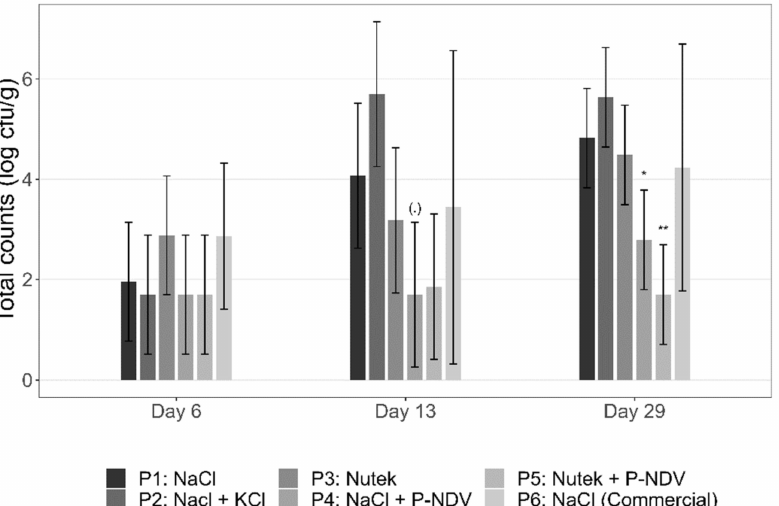
Figure 8. Total viable counts in industrially produced CS salmon with NaCl, sodium-reduced salts and variants with added Provian NDV preservative salt (products P1 through P6; Table 2). Expected means and 95% confidence intervals are displayed for P1-P6. Significant differences to the reference (P1) for each day are displayed with symbols (.) ( p < 0.1), * ( p < 0.05) and ** ( p < 0.01).